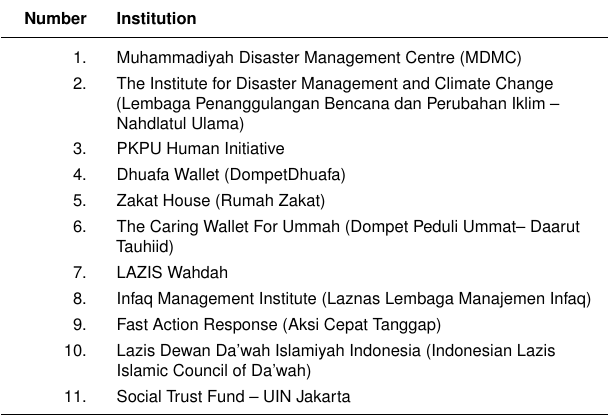
Table 1. Indonesian Humanitarian Institutions